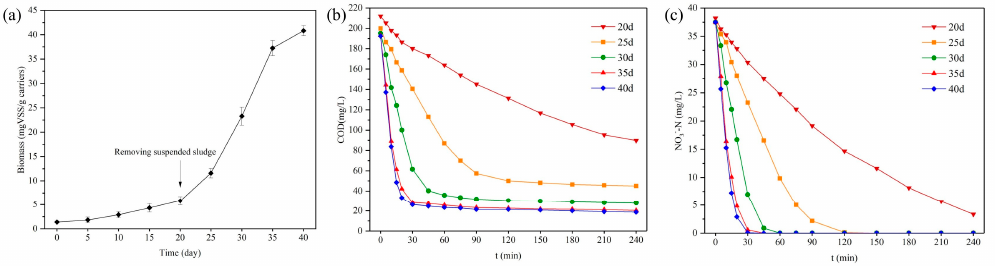
Figure 1. Variation of attached biomass on carriers ( a ) and removal of COD and NO 3 -N in different periods ( b , c ).